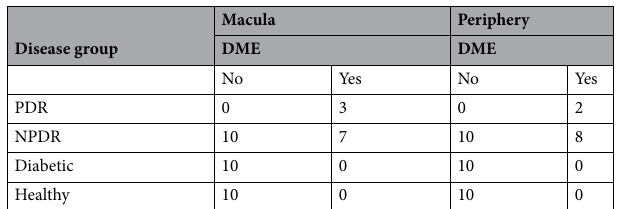
Table 1. Overview table of collected post-mortem human retina samples: the study contains four main sample groups (healthy control, diabetics without diagnosis of DR, NPDR, and PDR). In addition, donors are subdivided according to the occurrence of DME. Samples were taken from both retinal macula and retinal periphery. Throughout the manuscript NPDR/PDR + DME denotes the group of all donors with DME